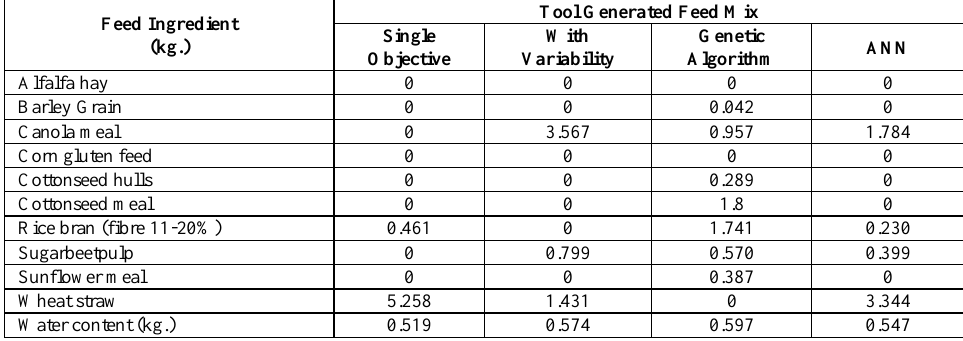
Table 3. Results of shelf-life maximization for dairy cattle feed mix Feed Ingredient